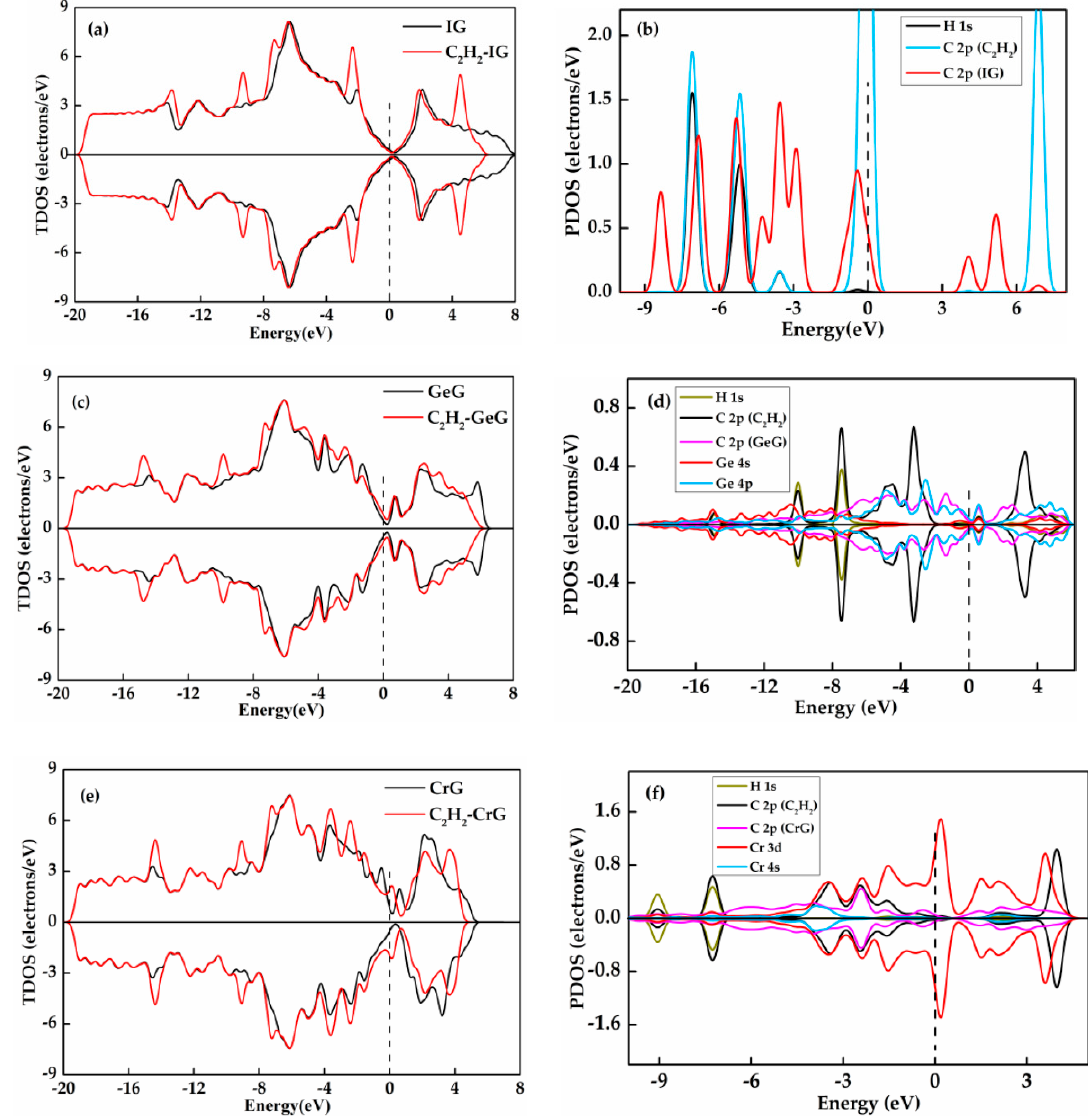
Figure 11. The TDOS and PDOS of C 2 H 2 adsorbed on IG ( a , b ), GeG ( c , d ) and CrG ( e , f ). By analyzing the charge density difference as shown in Figure 12, the electron transfer mechanism of GeG and CrG system is researched. Figure 12a shows the obvious contact of the electron occurrence region between the C 2 H 2 molecule and Ge atom, which infers a strong interaction between them because of a certain amount of transferred electron. A direct continuous electron region is found in Figure 12b, indicating that part of electron transfers between C and H atoms. In addition, the Cr atom is surrounded distinctly by red areas, while the C atom of C 2 H 2 is surrounded by blue areas. This phenomenon suggests that a mass of electrons transfer from the C 2 H 2 molecule to CrG system. The findings show that a strong chemical interaction appears between C 2 H 2 and CrG, and results in the appearance of a new Cr-C bond. The above conclusions are uniform with the consequences of the Mulliken analysis.